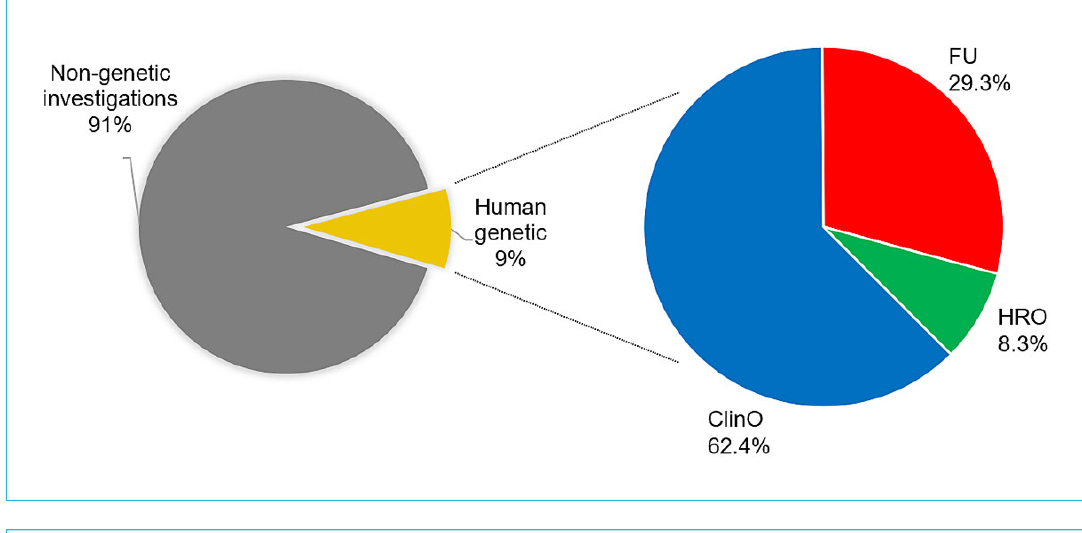
Figure 1: Distribution of genetic research in Switzerland in 2018. Overall, 2368 applications: 537 clinical trials, 844 research projects with per- sons, 987 further-use research projects, 205 of which were genetic investigations including 128 clinical trials, 17 research projects with per- sons and 60 further-use research projects